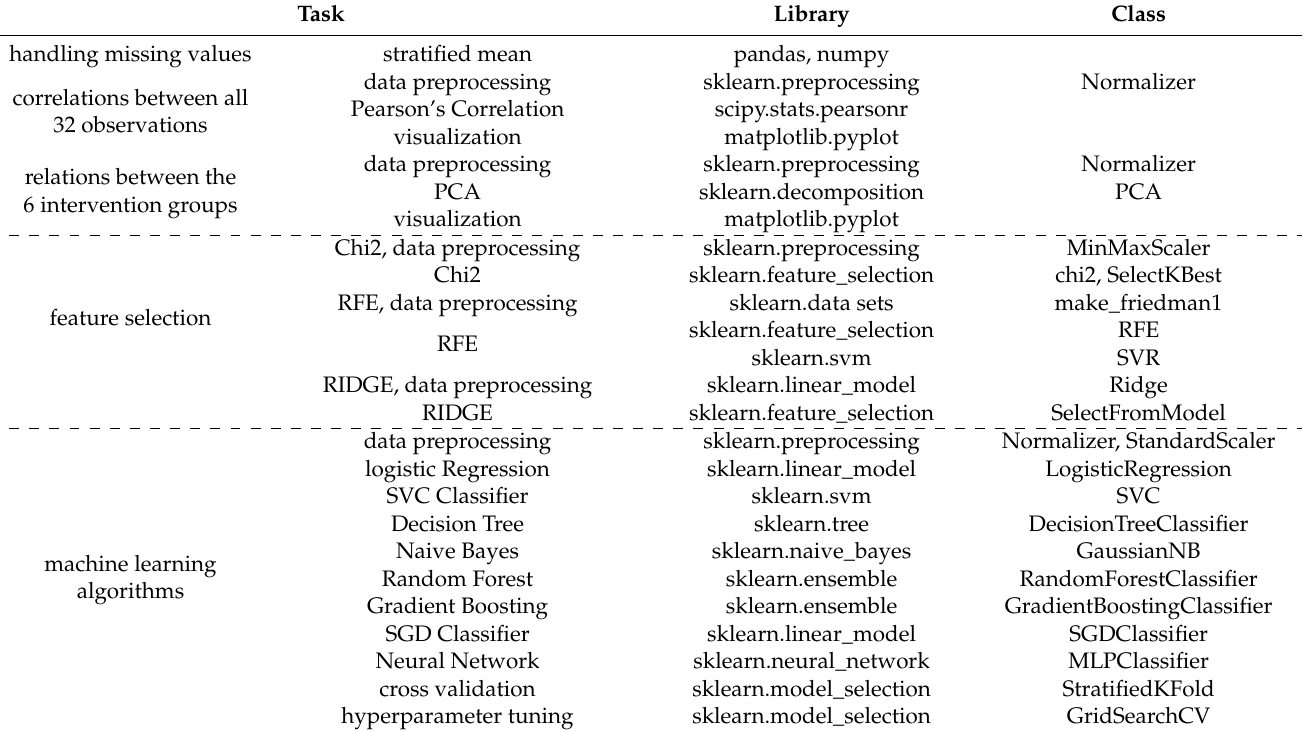
Table 1. List of applied algorithms with their respective implementations in